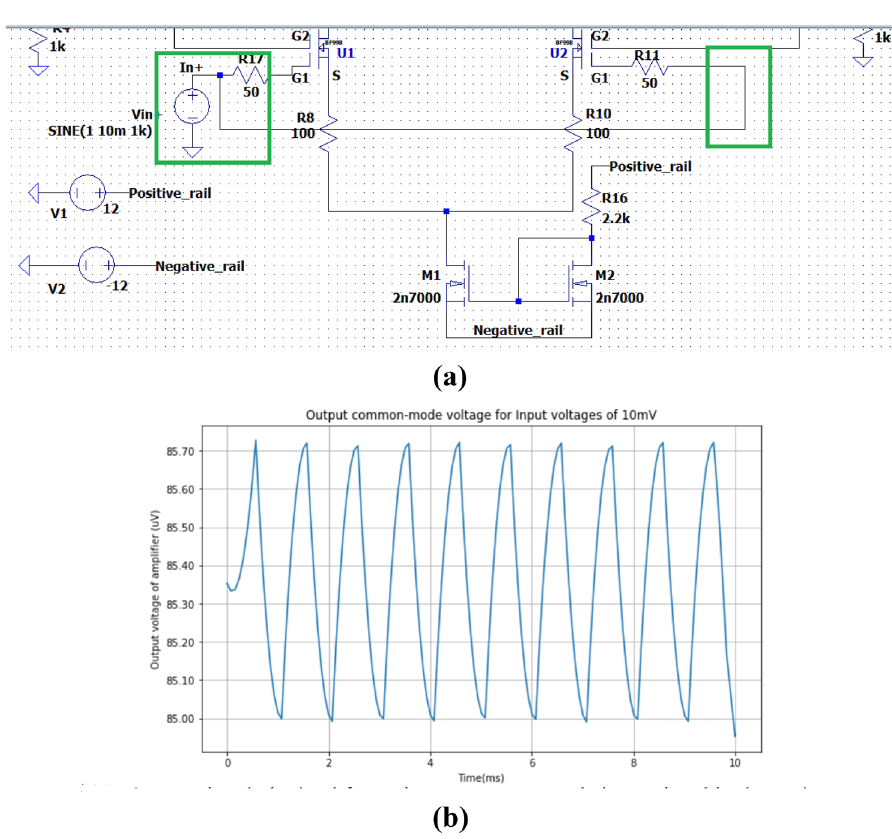
Fig. 9 a The 10 mV common- mode signal is applied to the differential amplifier, where the sinusoid input is shared (shown in green, at both inputs) to simulate common-mode signals and the output is observed. b Output signal obtained for an input common-mode input signal is shown in Fig. 9(a)